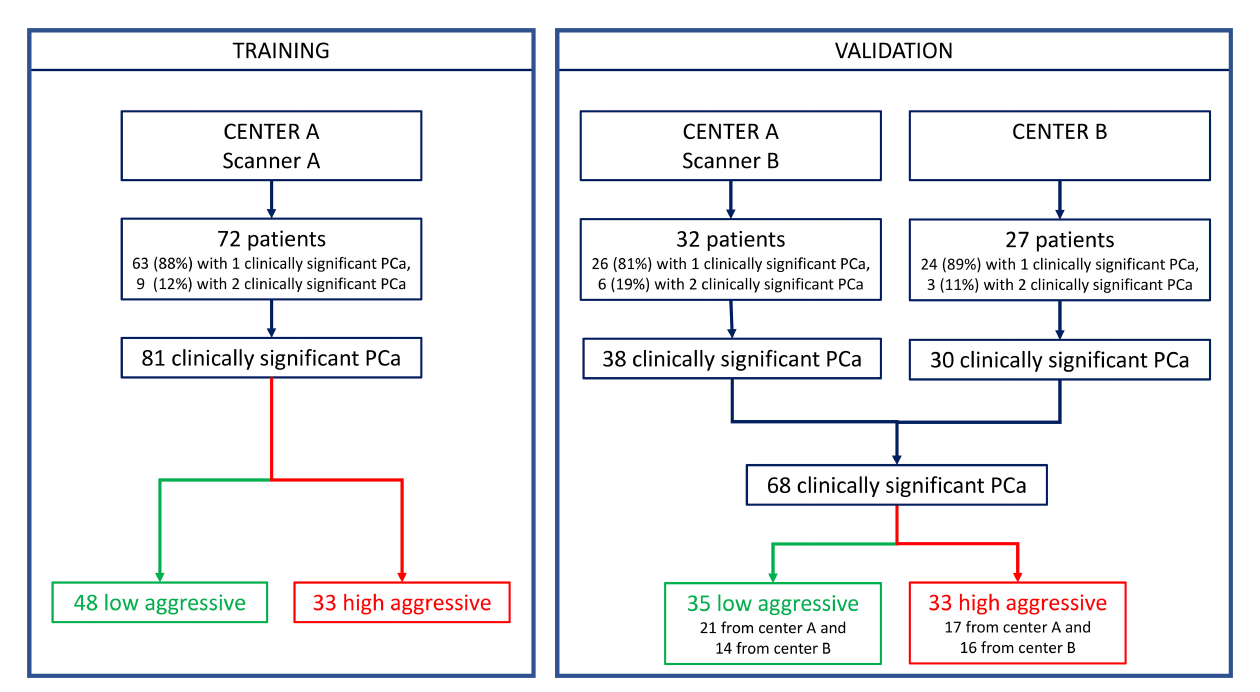
FIGURE 1 | Composition of training and validation